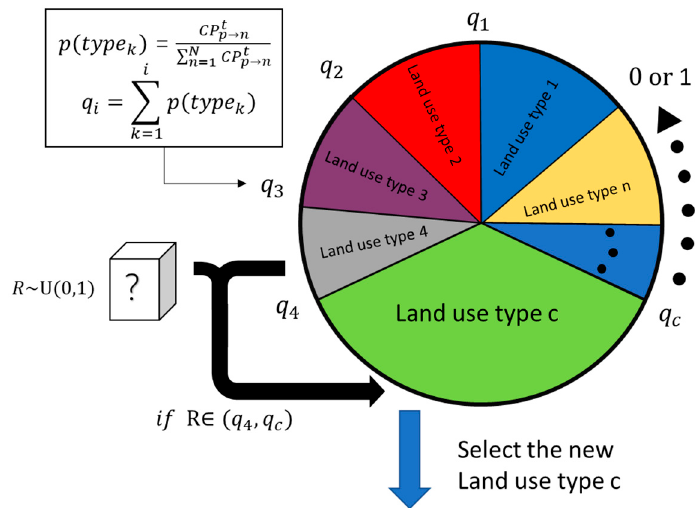
Figure 4. The roulette selection mechanism.